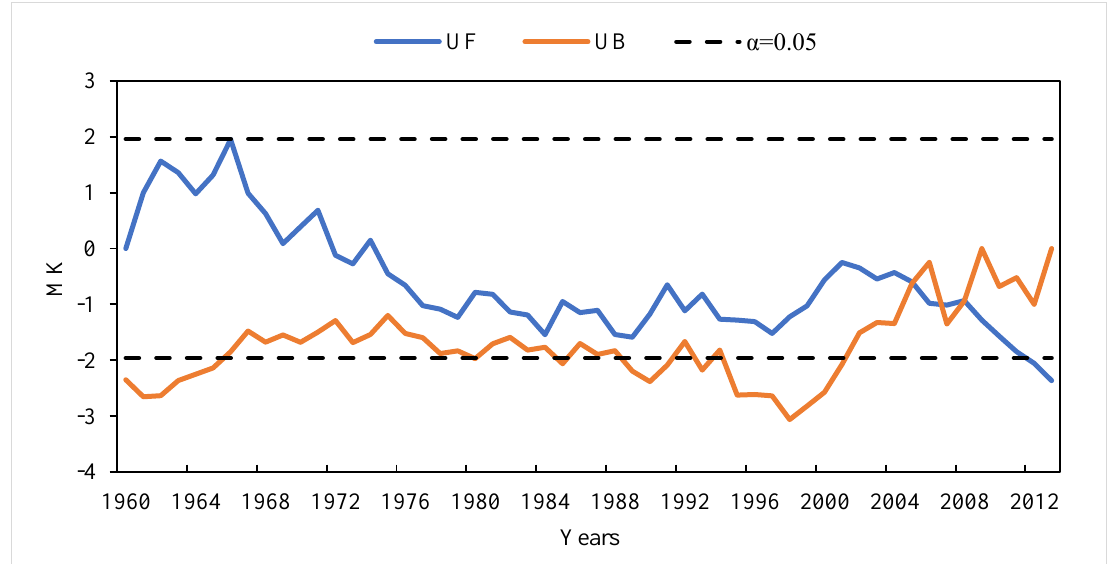
Figure 3. Hydrological and meteorological data of the Lancang River basin (1960 − 2013). ( a ) Hydro- logical data and ( b ) meteorological data.